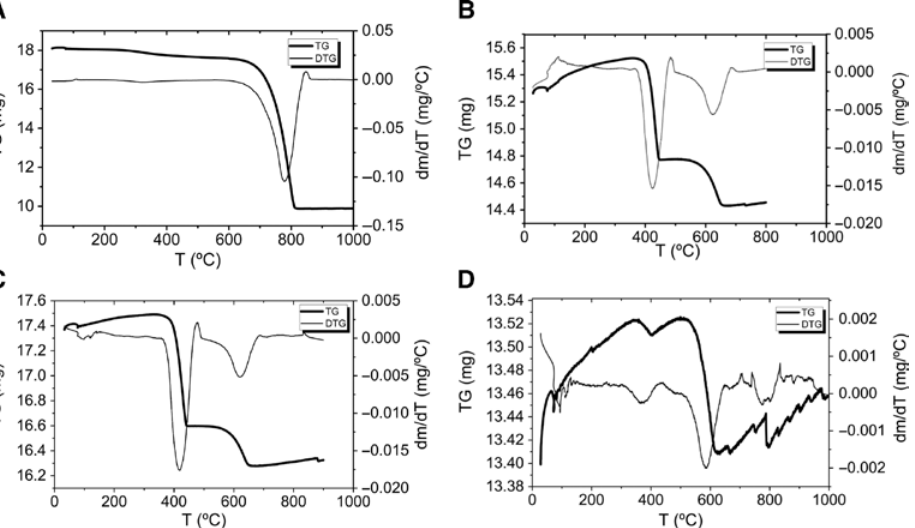
Figure 4: Thermogravimetric analysis (TGA) of (A) in natura eggshell, (B) eggshell calcined at 800 ° C, (C) eggshell calcined at 900 ° C and (D) eggshell calcined at 1000 ° C.